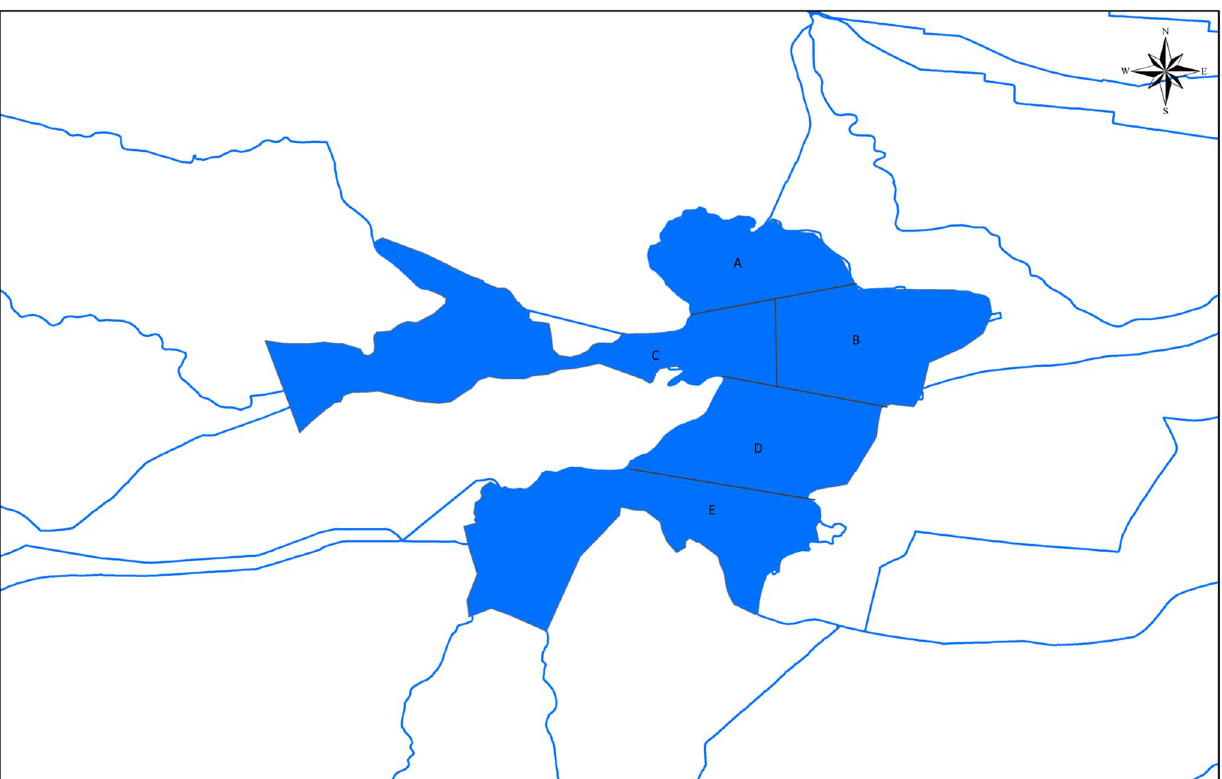
Figure 7. Five divided regions of the Baiyangdian wetland [ 32 ] . The Baiyangdian wetland was divided into 5 sub regions using hierarchical cluster analysis.